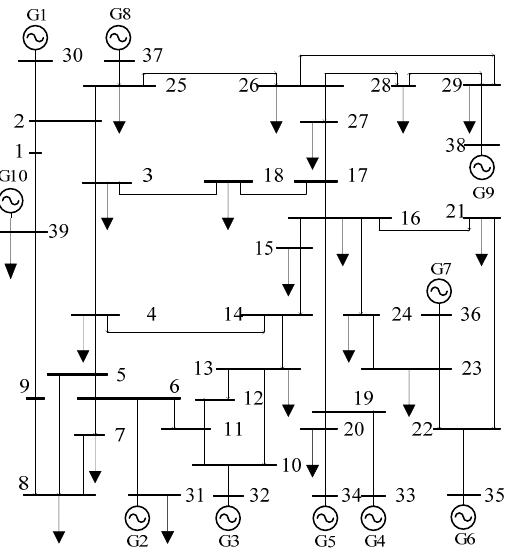
Figure 8. New England power system.